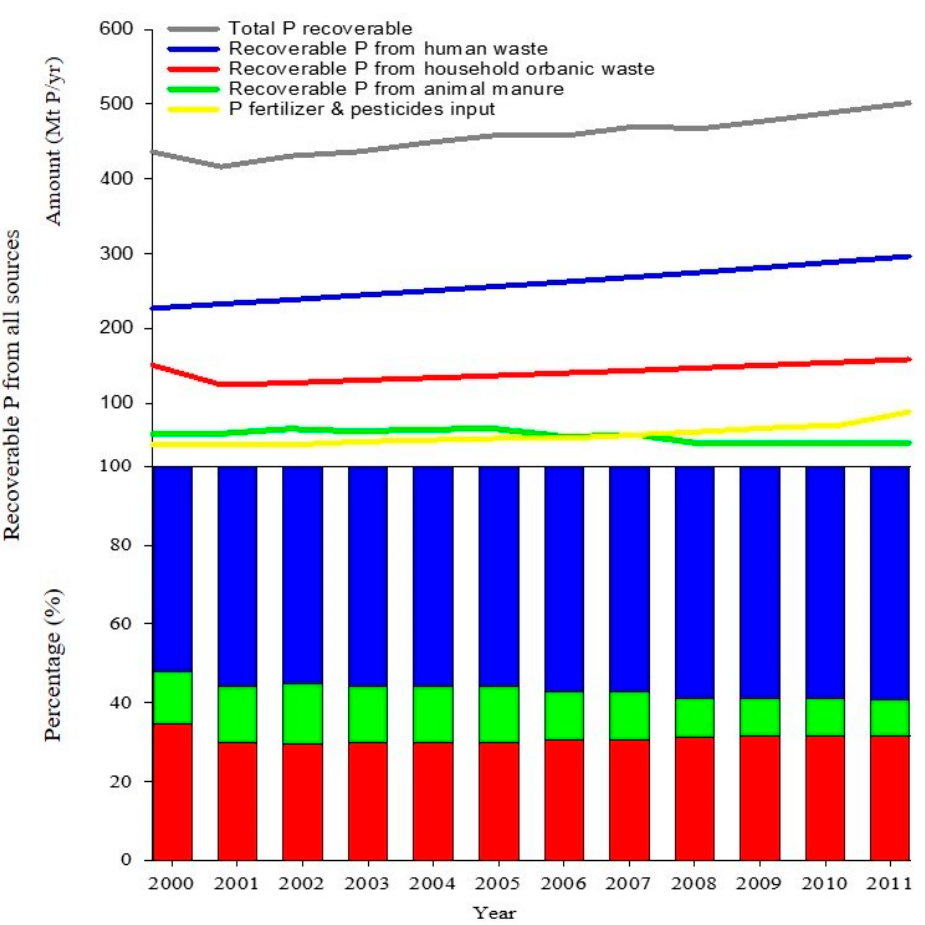
Figure 5. Recoverable P in Comoros for the period from 2000 to 2011. The upper portion represents the volume of P recovered from animal manure, household organic waste, and human waste sources. The lower portion represents the percentages for each source.